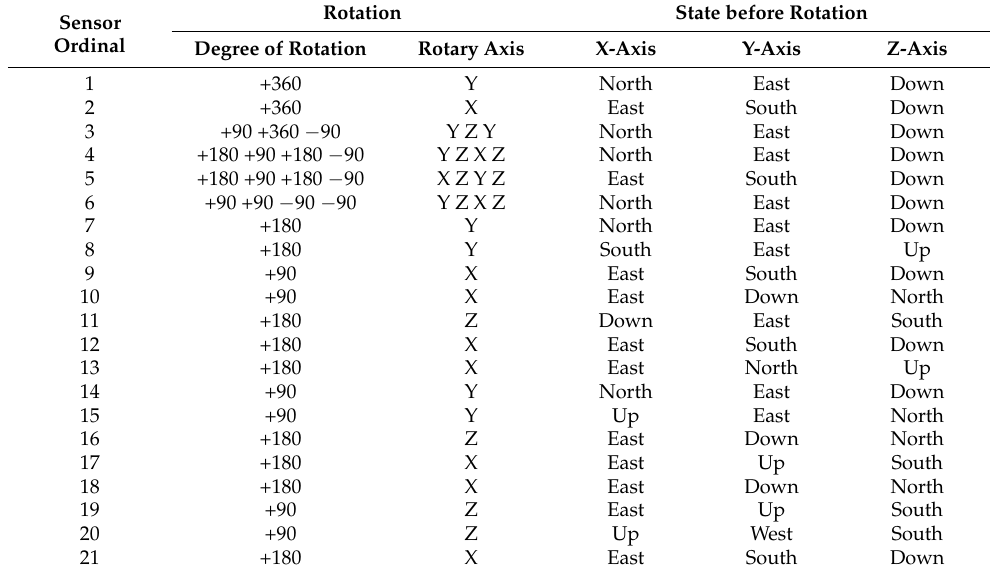
Table 1. Sensor position